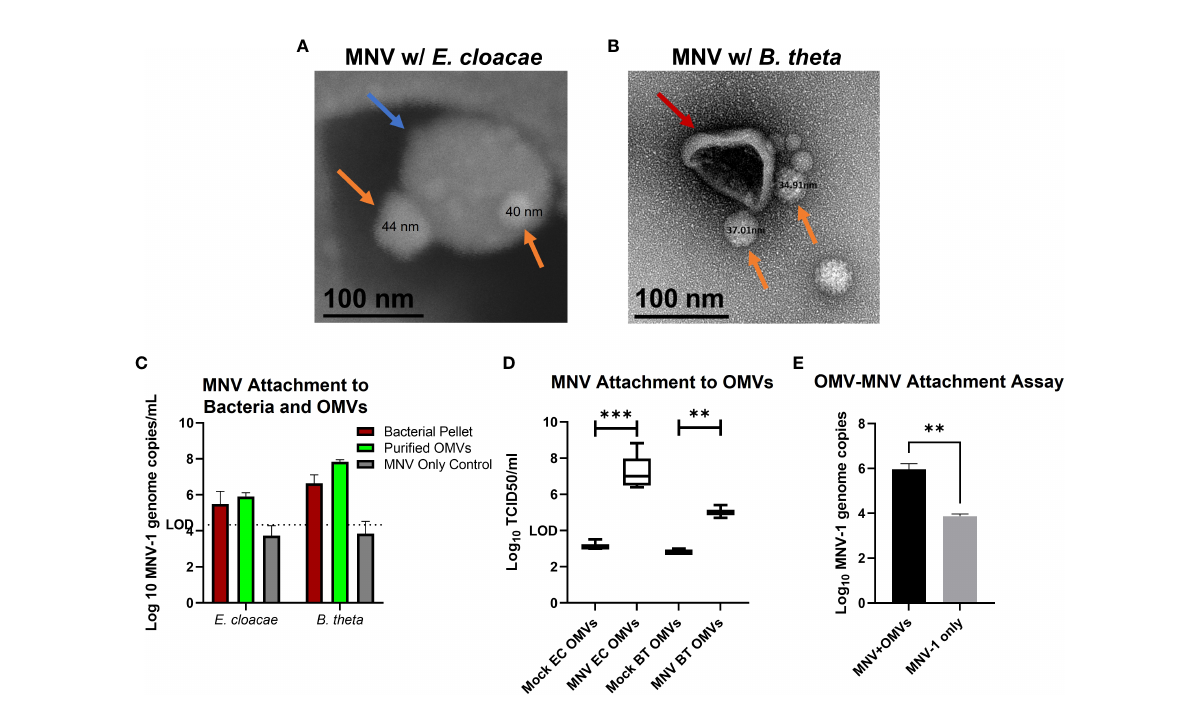
FIGURE 2 MNV attachment to OMVs. After incubation of bacterial culture with MNV, OMVs were collected by ultracentrifugation and MNV attachment to OMVs was assessed. (A) OMVs harvested from E cloacae cultures (blue arrow) were analyzed with scanning electron microscopy (SEM) to observe attached MNV (orange arrows). (B) OMVs derived from B thetaiotaomicron cultures (red arrows) were analyzed with transmission electron microscopy (TEM) to observe MNV (orange arrows) binding to OMVs, (C) RT-qPCR and (D) TCID 50 assay were performed to quantify the co-puri fi cation of MNV with OMVs harvested from E cloacae ( EC ) and B thetaiotaomicron (BT) cultures incubated with MNV, (E) OMVs were harvested from naïve bacterial cultures and subsequently incubated with MNV. RT-qPCR analysis was performed to quantify MNV binding to free- fl oating OMVs in the absence of the parental bacteria. **=p<0.01,